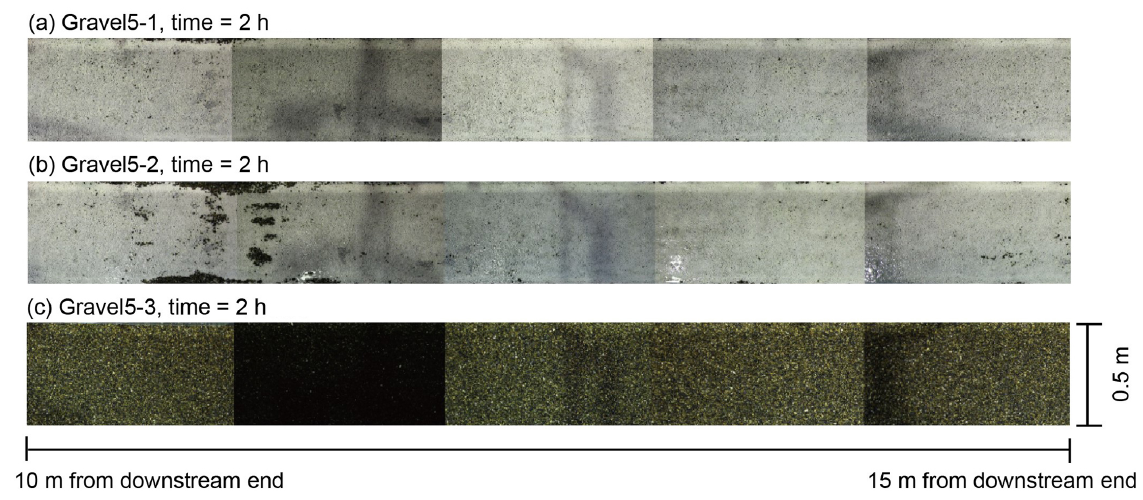
Figure 4. Bedrock exposure in Gravel5 series at the end of the experiment. The initial bed had 5mm embedded